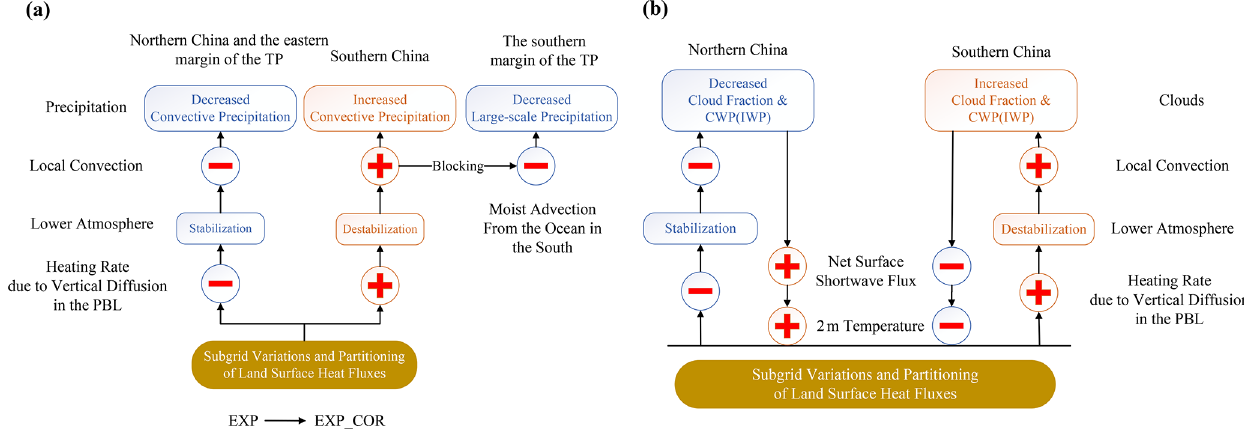
Figure 14. Schematic diagram summarizing the climate impacts of parameterizing subgrid variations and partitioning of land surface heat fluxes to the